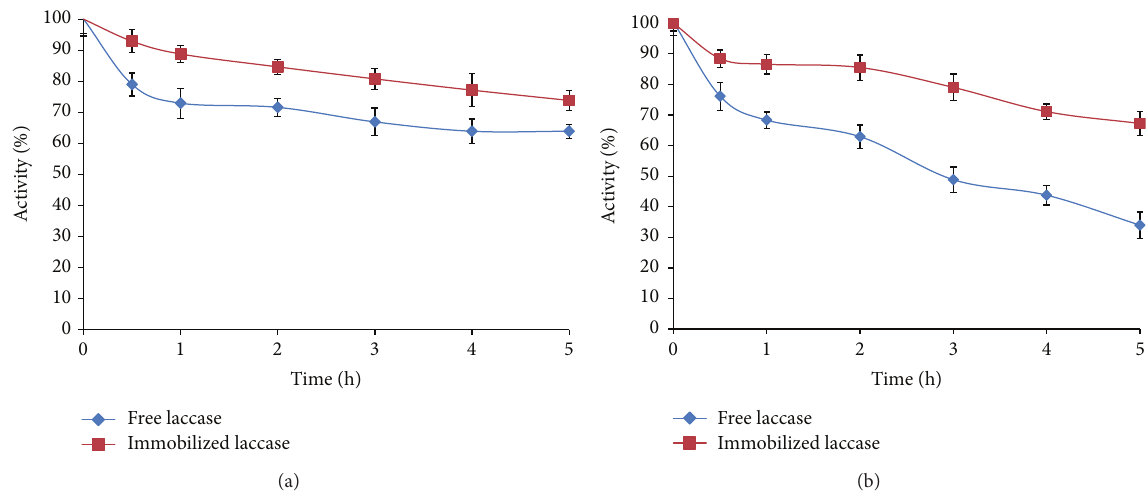
Figure 7: Thermal stability profile of the free and immobilized laccase at 55 ∘ C (a) and 65 ∘ C (b).